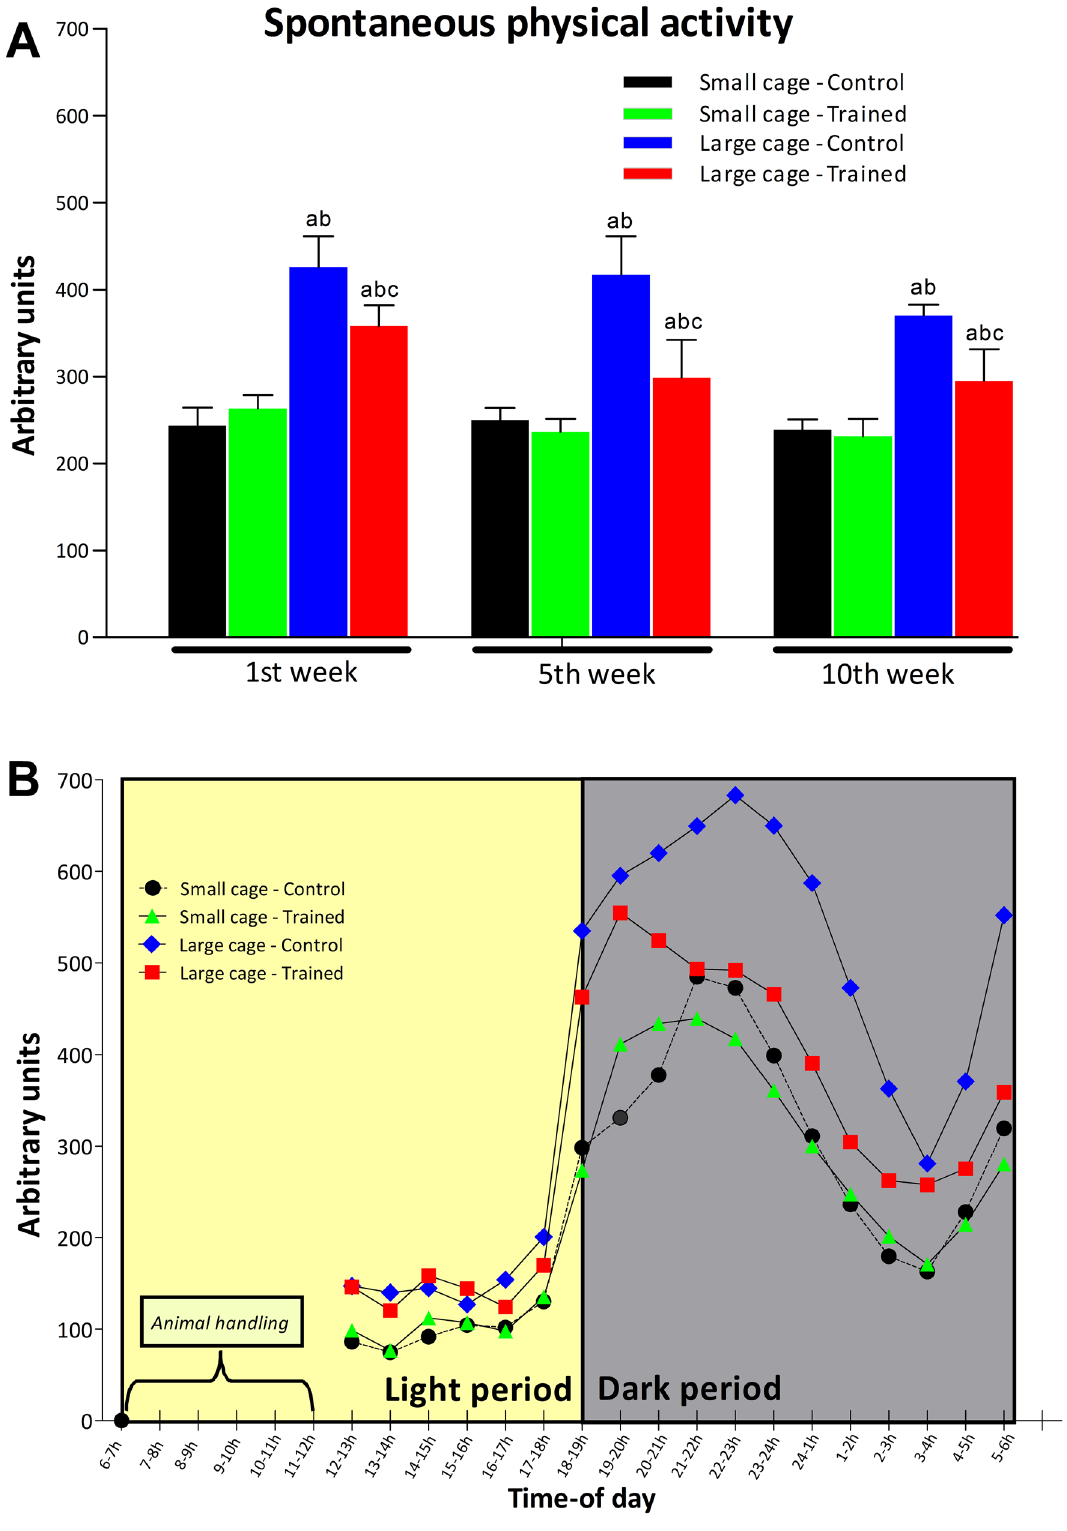
Figure 3. ( A ) shows weekly average SPA in the first, fifth and tenth weeks for the control (C) and trained (T) groups kept in small cage (SC) and large cage (LC). A time-of-day variation of SPA is exhibited in ( B ) demonstrating the robustness and sensibility of gravimetric method. This analysis considers all SPA records obtained in first, fifth and tenth weeks (N = 21 for each hour-time interval from 12:00 to 6:00 h). Animal handling (between 6:00 and 12:00 h) includes HIIT, cage cleaning and weighting control. SPA was measured on a per cage basis (10 mice per cage). Statistical significance symbols: a—different from SC-C, b—different from SC-T and c—different from LC-C within the same experimental week (P <